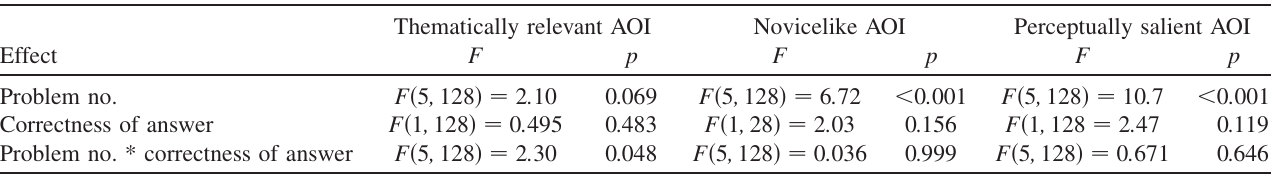
TABLE V. Results of mixed factorial ANOVA for all three AOI types for first 2 sec of viewing the diagram. * indicates an interaction of the effects of problem number and correctness of answer.